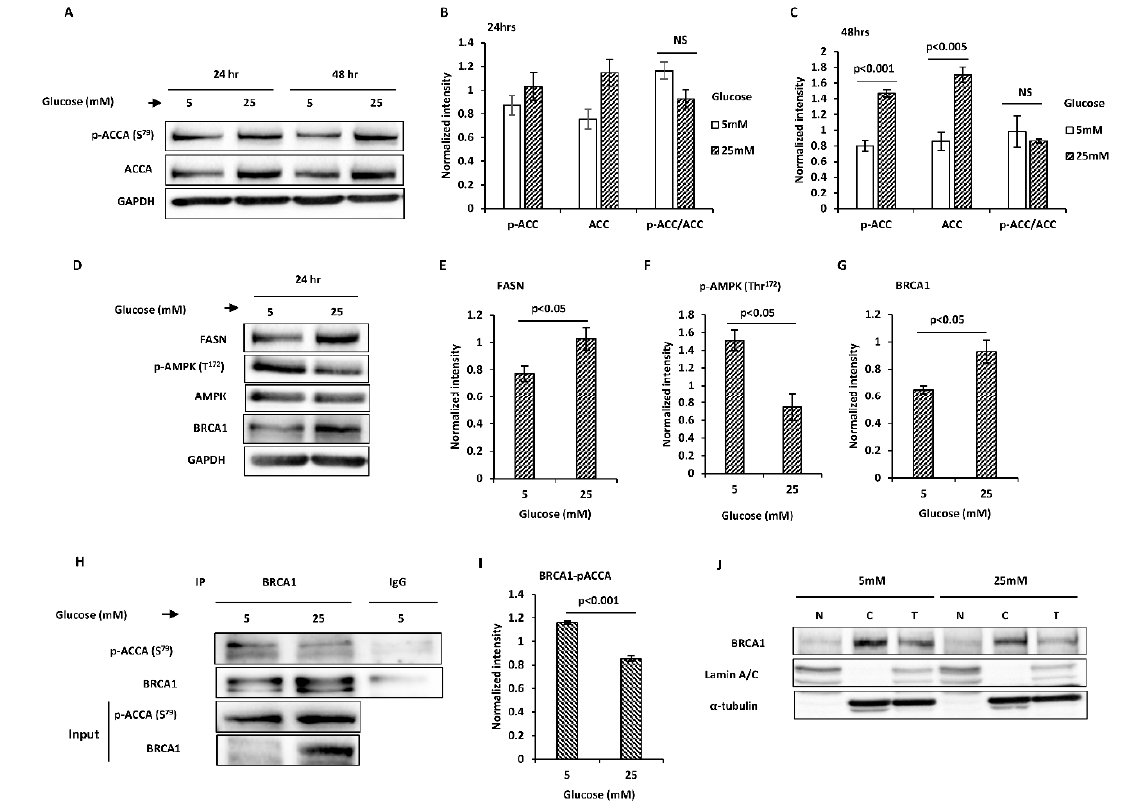
Figure 1. High glucose regulates key lipogenic proteins by glucose in MCF7 breast cancer cells. Cells were exposed to normal and high glucose for 24 and 48 h. ( A ) Representative immunoblots of total acetyl CoA carboxylase (ACCA) and p-ACCA (S 79 ) are shown. ( B , C ) Densitometry analysis of total ACCA normalised to glyceraldehyde 3-phosphate dehydrogenase (GAPDH) and p-ACCA (S 79 ) normalised to both GAPDH and total ACCA. ( D ) Representative immunoblots of fatty acid synthase (FASN), total AMP-activated protein kinase (AMPK), p-AMPK (Thr 172 ) and breast cancer 1, early onset (BRCA1) are shown. ( E – G ) Densitometry analysis of p-AMPK (Thr 172 ) normalised to total AMPK and FASN and BRCA1 normalised to GAPDH. ( H ) Lysates from cells exposed to normal and high glucose for 24 h were subjected to immunoprecipitation with 2 µ g anti-BRCA1 antibody or negative control IgG, followed by Western blotting using BRCA1 and p-ACCA (S 79 ) antibodies. Input represent lysates not used for immunoprecipitation. ( I ) The graph shows signal of precipitated p-ACCA (S 79 ) normalised to BRCA1. ( J ) Western blot analysis of cytoplasmic and nuclear fractions from cells exposed to low and high glucose for 24 h. Lamin A / C and α -tubulin were used as nuclear and cytoplasmic markers, respectively. All results shown are representative of three independent experiments and the graphs represent mean ± SEM. Independent samples t -test was used to compare means of 2 groups.